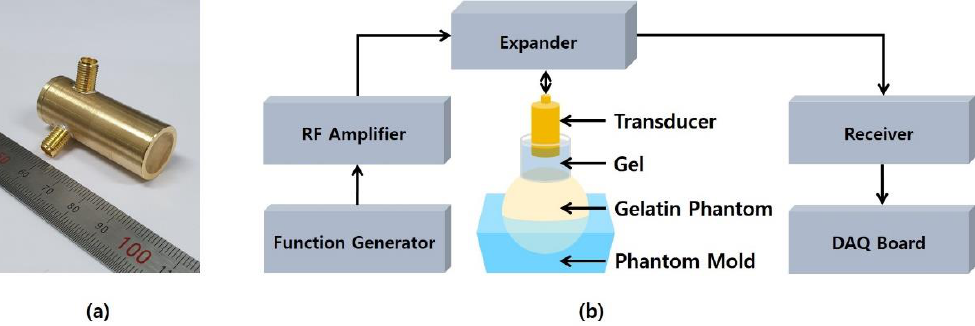
Figure 4. ( a ) Photograph of the 5 MHz prototype ultrasound transducer and ( b ) block diagram of experimental setup using gelatin phantoms with various stiffness values.